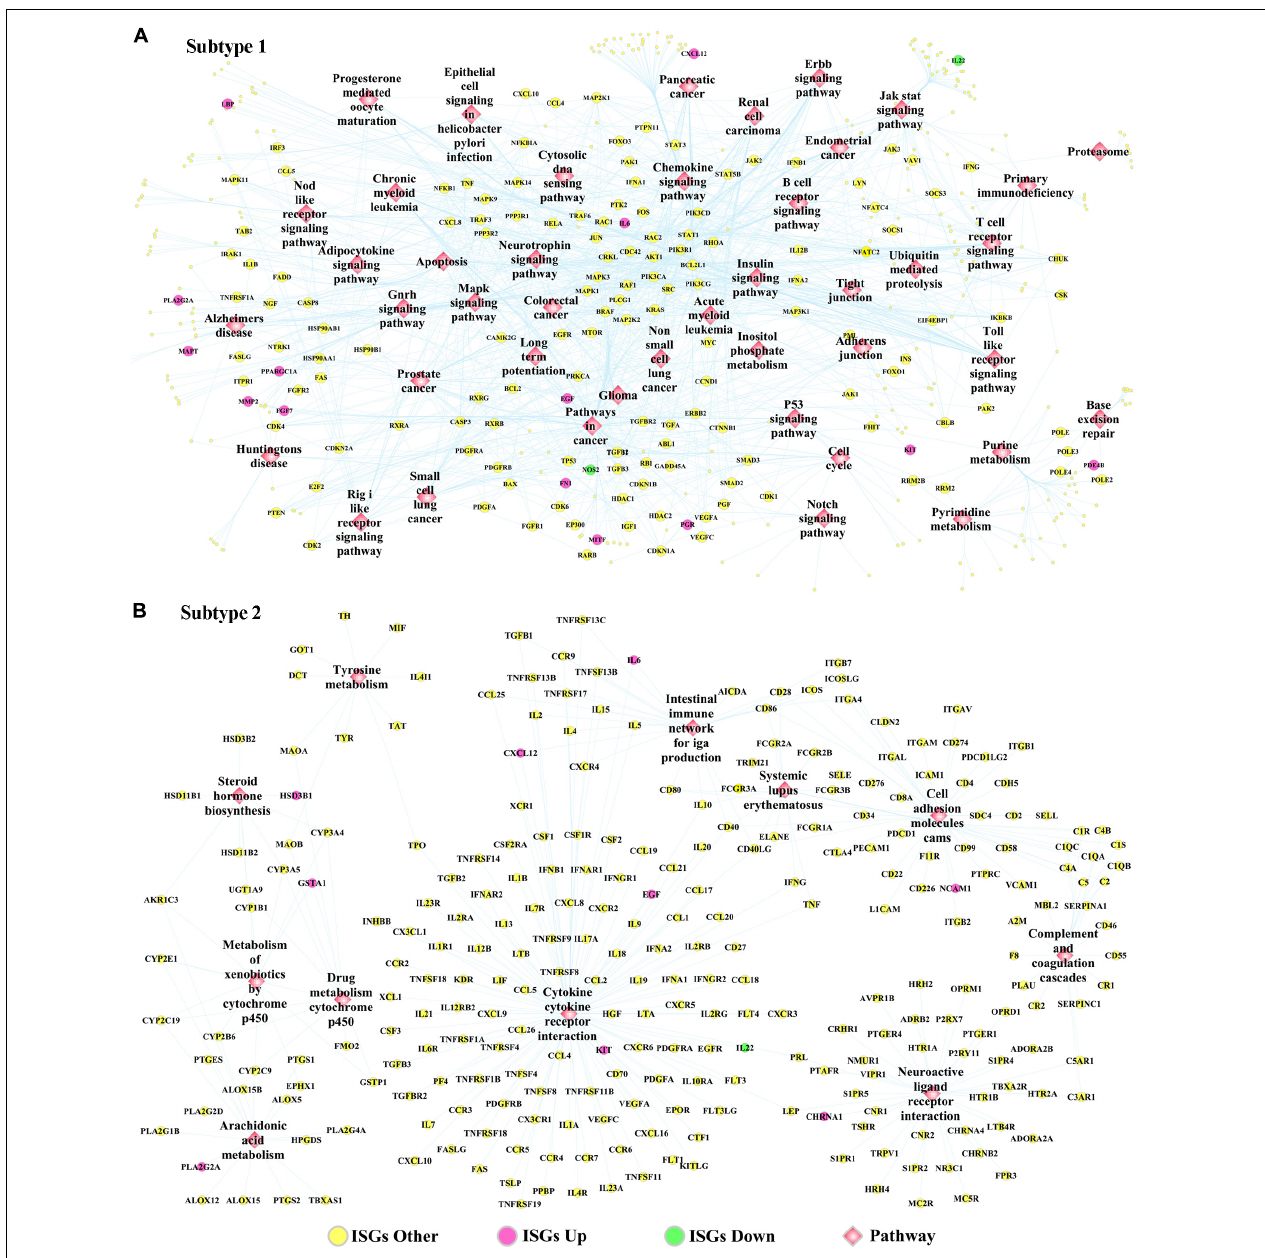
FIGURE 6 | The ISGs-pathways interaction network in OSCC samples of panel (A) subtype Sub1 and panel (B) subtype Sub2. The rose-red round nodes represent ISGs that were DEGs upregulated between two subtypes of OSCC, the emerald round nodes represent ISGs that were also DEGs downregulated between two subtypes of OSCC, the yellow round nodes represent ISGs that were not DEGs dysregulated between two subtypes of OSCC, and the diamond nodes represent the signaling pathways targeted by